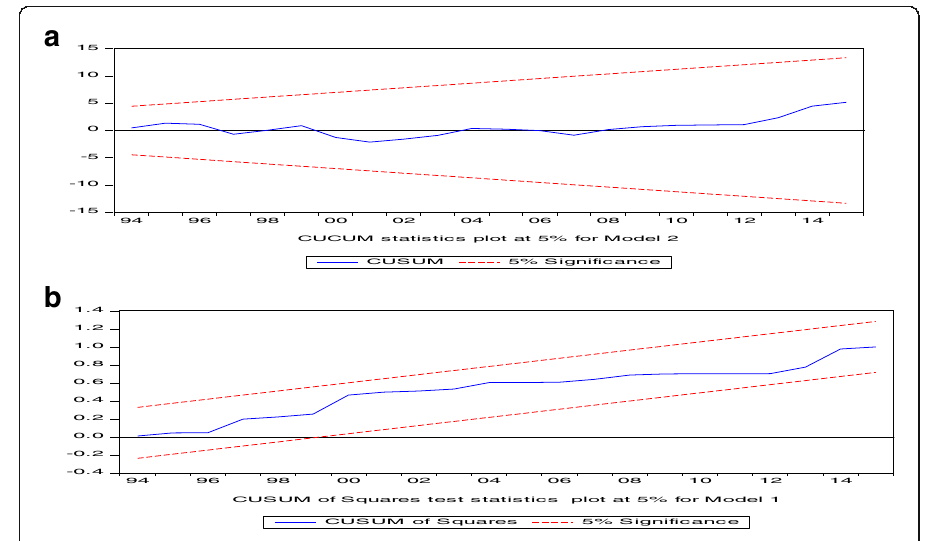
Fig. 3 a CUCUM statistics plot at 5% for Model 2. b CUSUM of Squares test statistics plot at 5% for Model 1